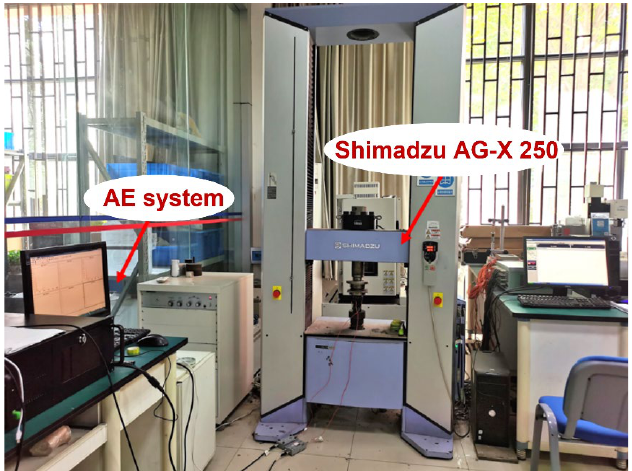
Figure 4. Test equipment diagram.